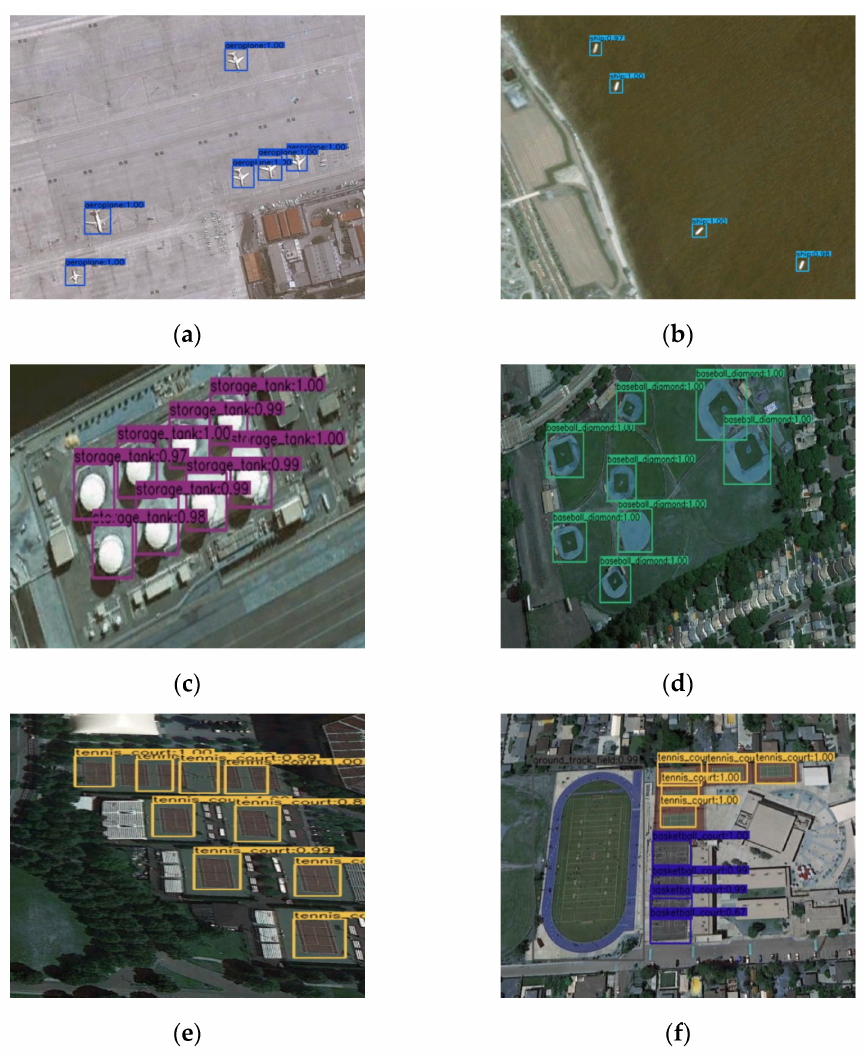
Figure 6h and the bridge in Figure 6i), but also effective for small objects. For example, it can detect the small ship object in Figure 6b and the Vehicle small object in Figure